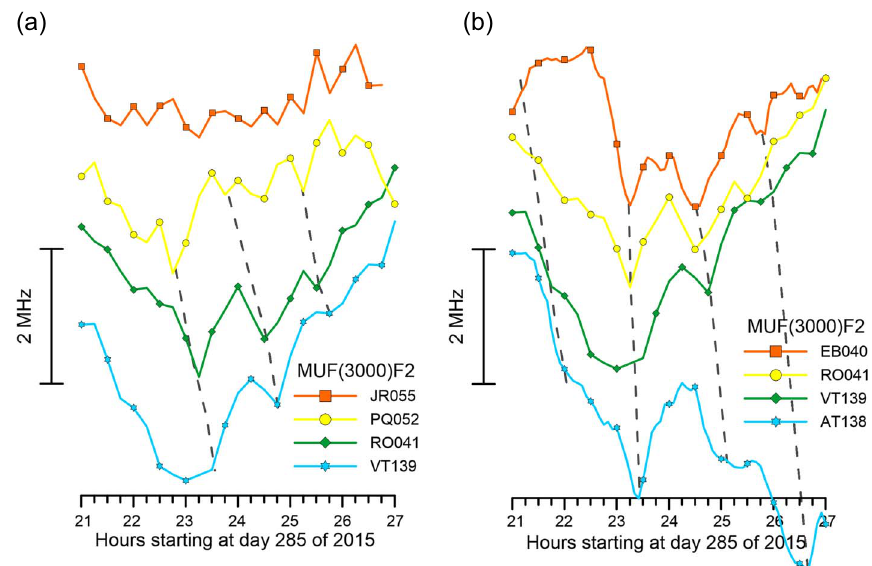
Fig. 3. (a) Time variation of the MUF(3000)F2 recorded at several Digisonde stations arranged by latitude; and (b) arranged by